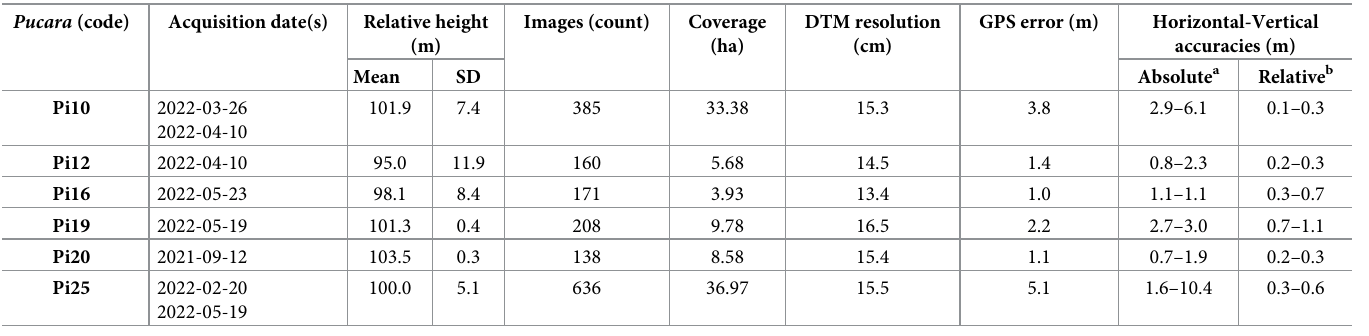
Table 4. Flight campaigns description and summary of the obtained